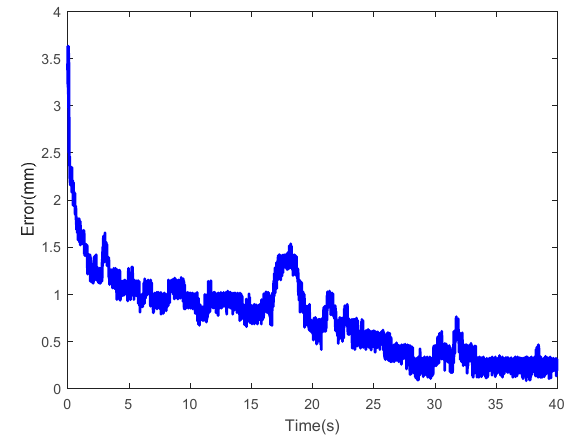
Figure 46. Control error at constant input displacement of 4mm.